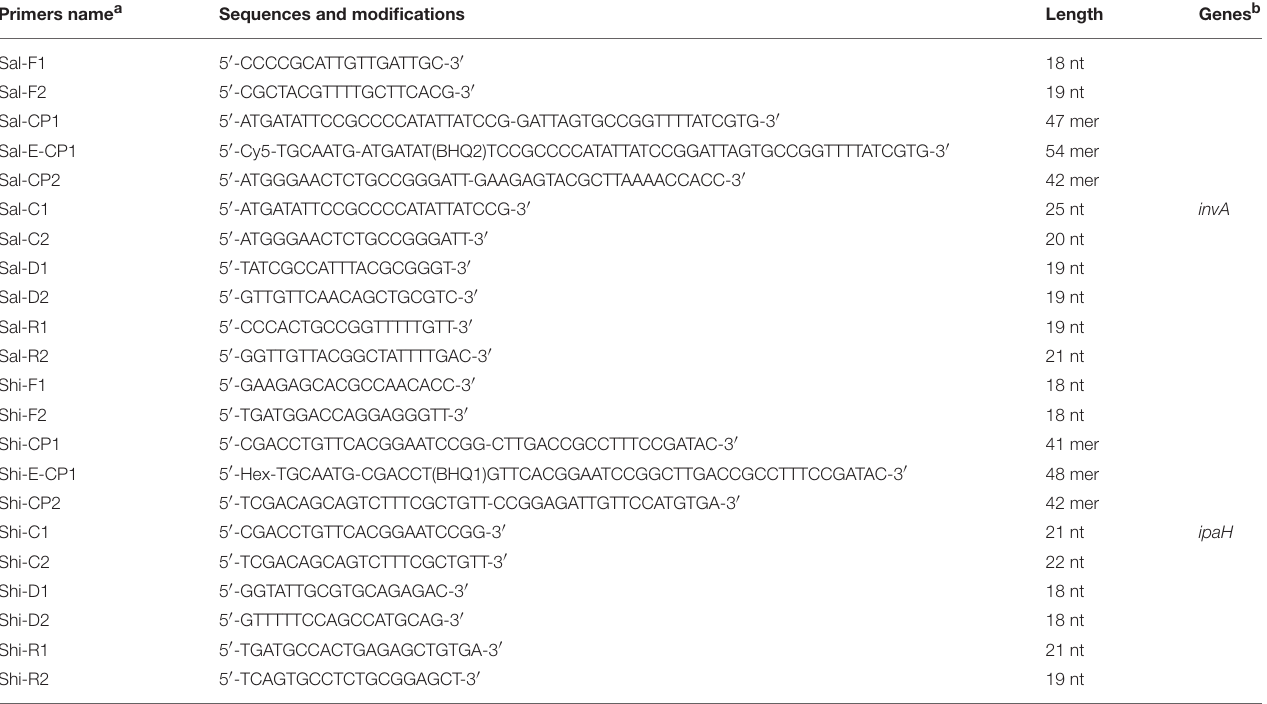
TABLE 1 | The primers used in the